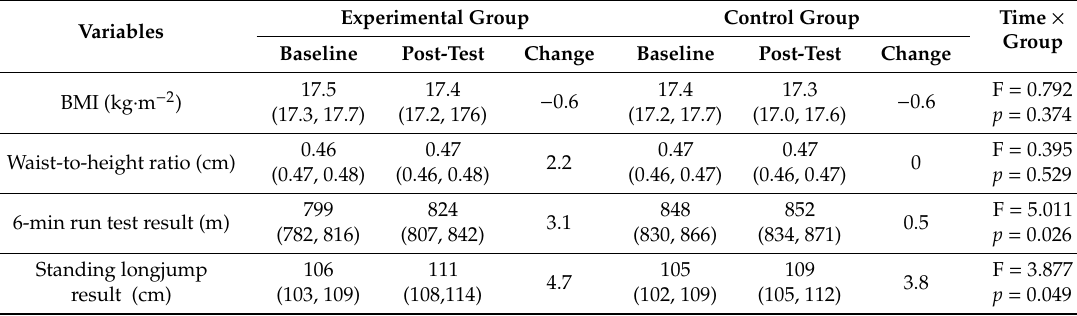
Table 2. Linear mixed model results of each dependent